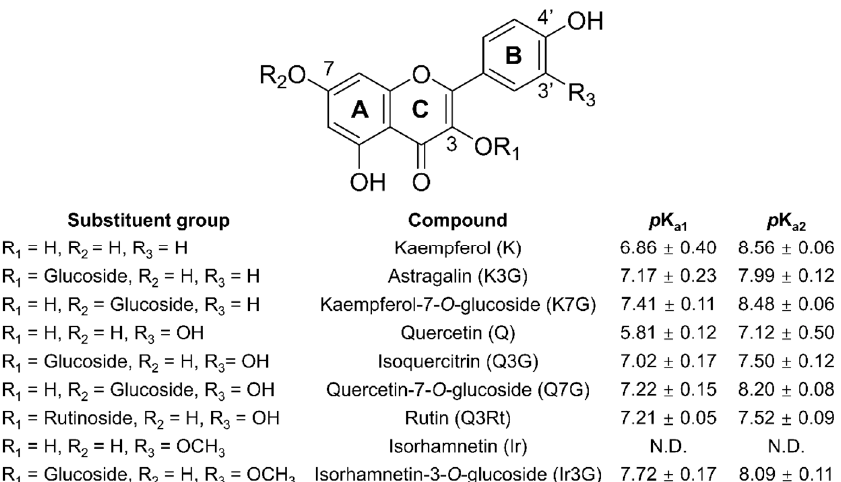
Figure 1. Chemical structures of flavonols and p K a values of the